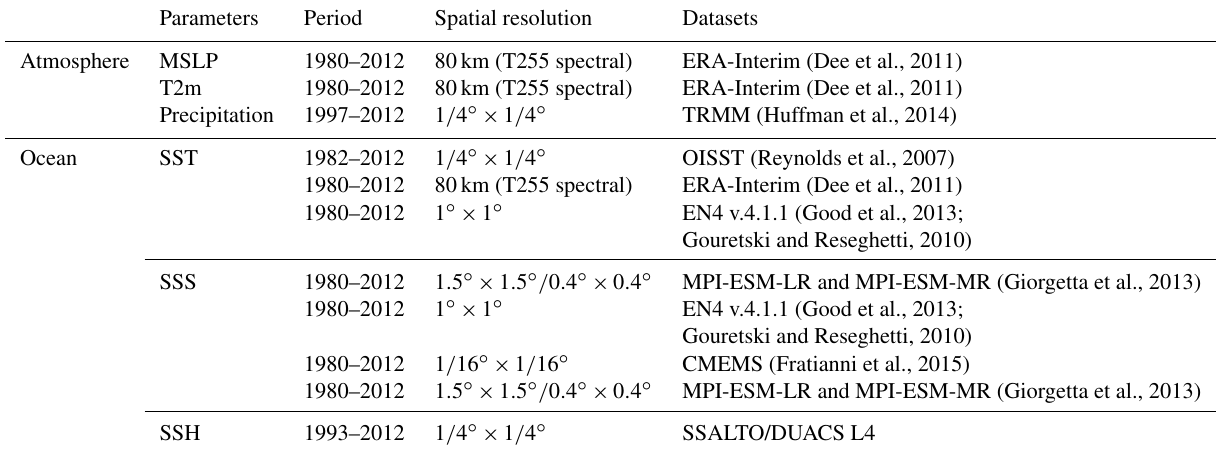
Table 2. Datasets used in the ROM